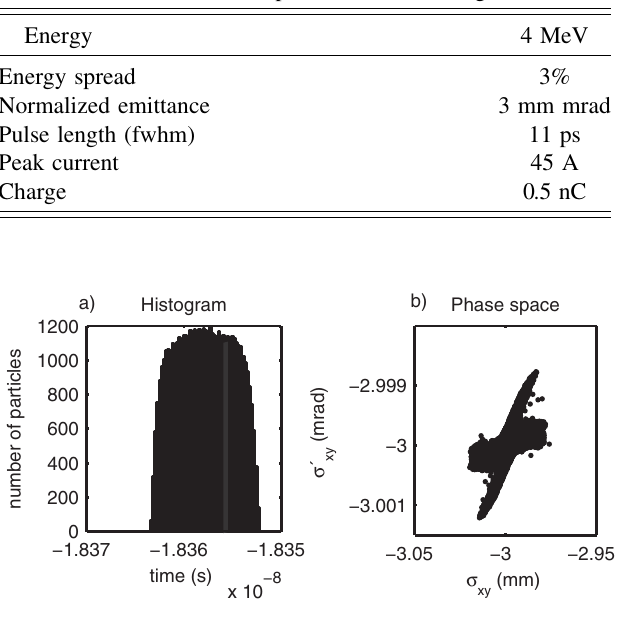
FIG. 2. Time structure (a) and transversal phase space (b) of the electron beam after the